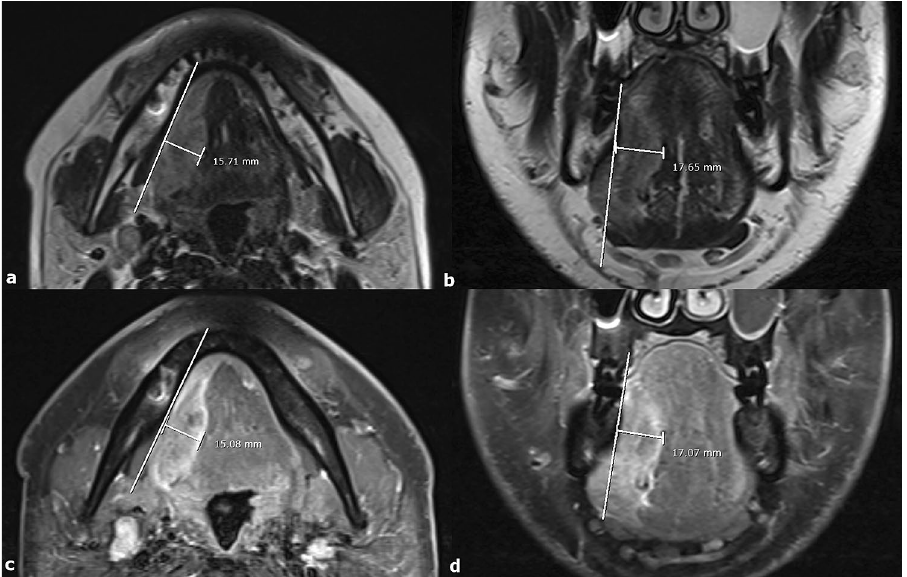
Figure 6. Representative measurements of MRI-measured tumor thickness (MRI-TT) on ( a ) axial T2WI, ( b ) coronal T2WI, ( c ) axial CE-T1WI with fat suppression, and ( d ) coronal CE-T1WI with fat suppression in a 39-year-old male patient diagnosed with tongue squamous cell